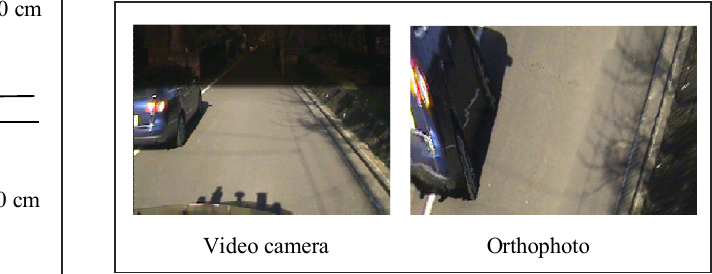
Video camera Figure 5. Reflection of a parked